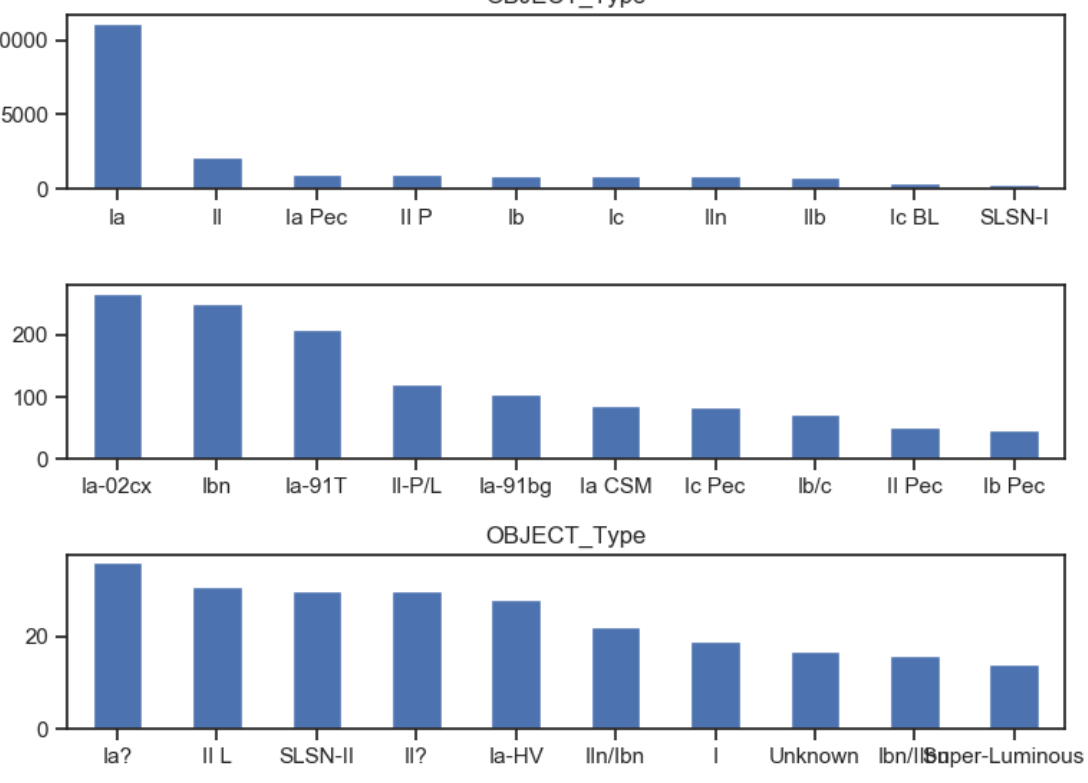
Figure 10. SNe type distribution.